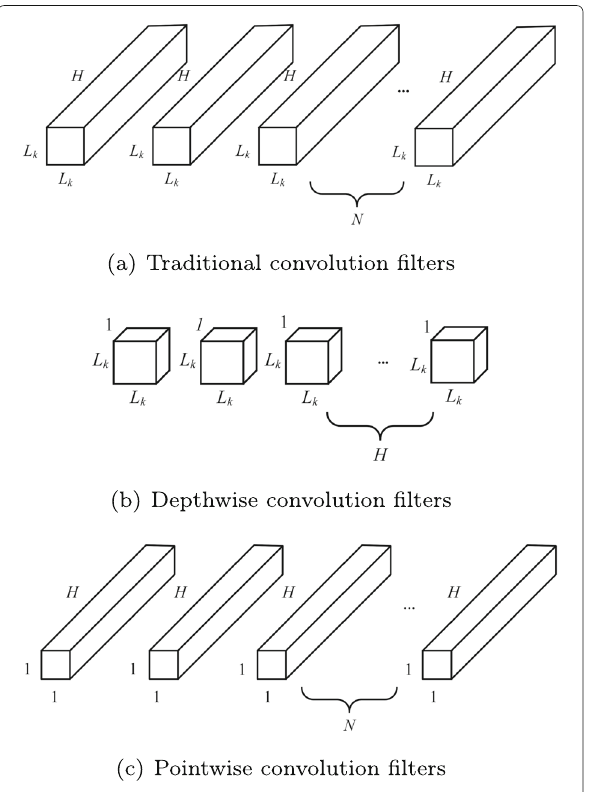
Fig. 3 Dilated convolution process